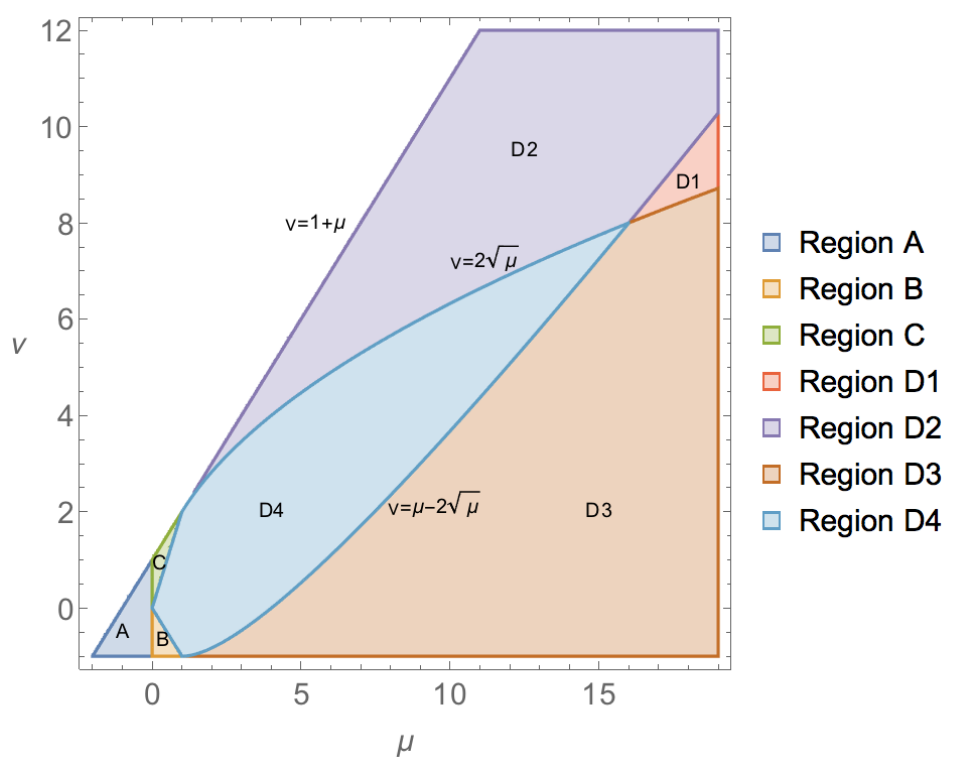
Figure 2 . Plot of the ( (cid:22); (cid:23) ) parameter space for regions